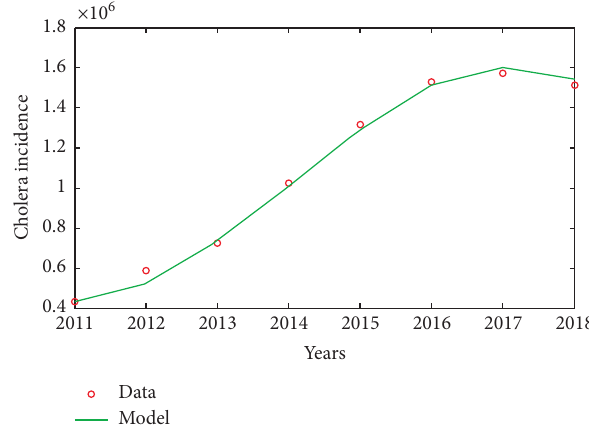
Figure 2: A plot showing the fitted model using the least square method for reported infected cholera cases.